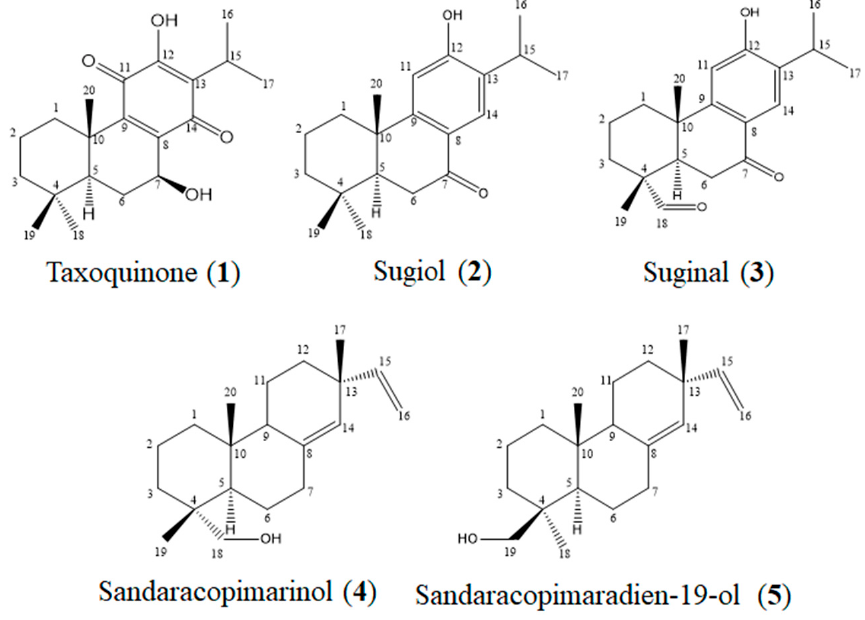
Figure 2. The chemical structures of the compounds isolated from M. glyptostroboide .